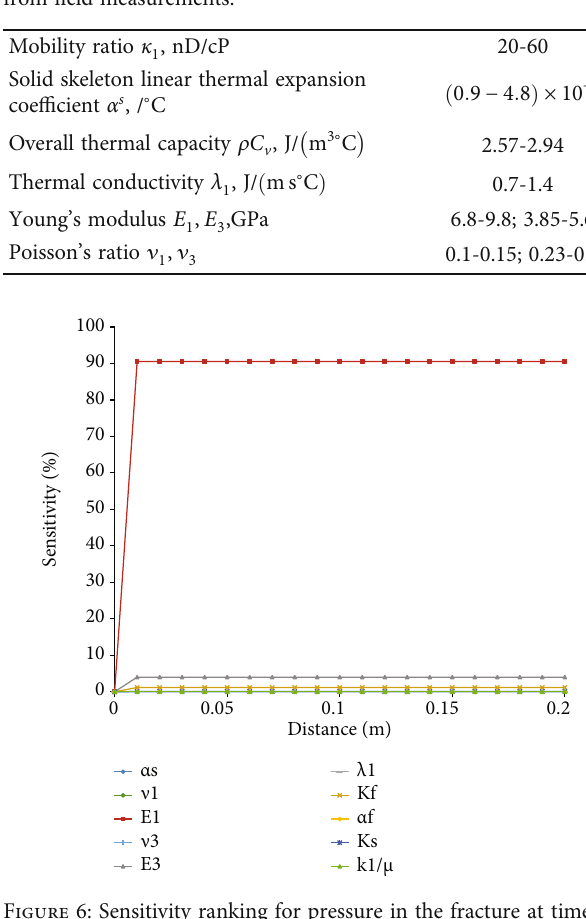
Table 3: Variability of some Woodford shale formation properties from fi eld measurements.